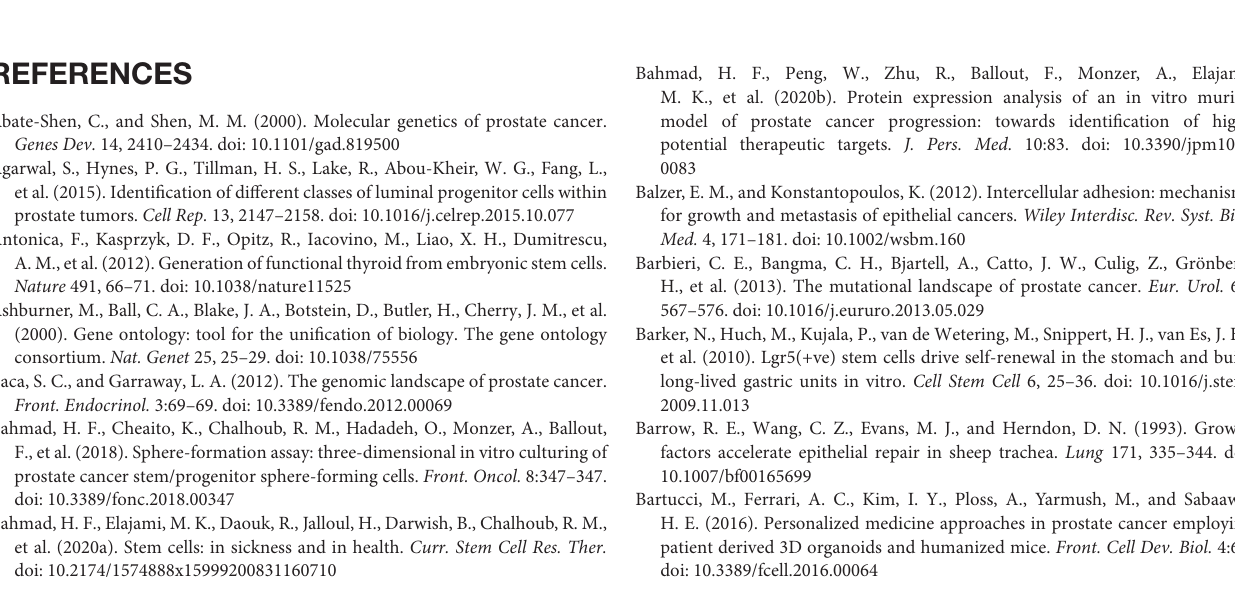
Supplementary Table 6 | List of all differentially expressed genes (DEGs) between AUB-PrC cells and their tissue counterparts in tumor samples. Supplementary Table 7 | List of all differentially expressed genes (DEGs) between AUB-PrC cells and their tissue counterparts that are unique to unaffected samples (543), unique to tumor samples (1410), and common between the two (2840). Supplementary Table 8 | List of biological processes identified that are unique to the unaffected AUB-PrC cells vs. tissue. There were 41 terms showing top five significant enrichments of GO:0043065˜positive regulation of apoptotic process (16 genes), GO:0001755˜neural crest cell migration (6 genes), GO:0045746˜negative regulation of Notch signaling pathway (5 genes), GO:2000379˜positive regulation of reactive oxygen species metabolic process (5 genes), and GO:0090074˜negative regulation of protein homodimerization activity (3 genes). Supplementary Table 9 | List of biological processes identified that are unique to the tumor AUB-PrC cells vs. tissue. There were 58 terms showing top five significant enrichments of GO:0006887˜exocytosis (14 genes), GO:0045909˜positive regulation of vasodilation (8 genes), GO:0051090˜regulation of sequence-specific DNA binding transcription factor activity (7 genes), GO:0001525˜angiogenesis (25 genes), and GO:0019233˜sensory perception of pain (10 genes). Supplementary Table 10 | List of biological processes identified that are common between unaffected and tumor AUB-PrC cells vs. tissue. There were 414 terms showing top five significant enrichments of GO:0007155˜cell adhesion (158 genes), GO:0030198˜extracellular matrix organization (83 genes), GO:0007165˜signal transduction (249 genes), GO:0006954˜inflammatory response (109 genes), and GO:0006955˜immune response (109 genes). Supplementary Table 11 | Gene set annotations of the enrichment map presented in Figure 6A corresponding to the unaffected AUB-PrC cells vs. tissues identified using Cytoscape 3.7.2 software (EnrichmentMap tool). Supplementary Table 12 | Gene set annotations of the enrichment map presented in Figure 6A corresponding to the tumor AUB-PrC cells vs. tissues identified using Cytoscape 3.7.2 software (EnrichmentMap tool). Supplementary Table 13 | Signaling pathways that are activated in unaffected AUB-PrC cells vs. tissues identified using gene set enrichment analysis (GSEA). Supplementary Table 14 | Signaling pathways that are activated in tumor AUB-PrC cells vs. tissues identified using gene set enrichment analysis